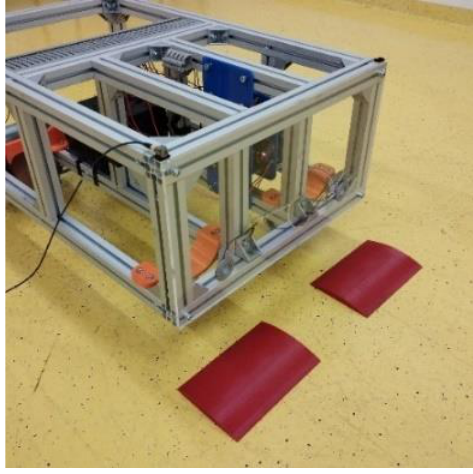
Figure 14. Position of the sensor in the upper right corner of the frame — photo.